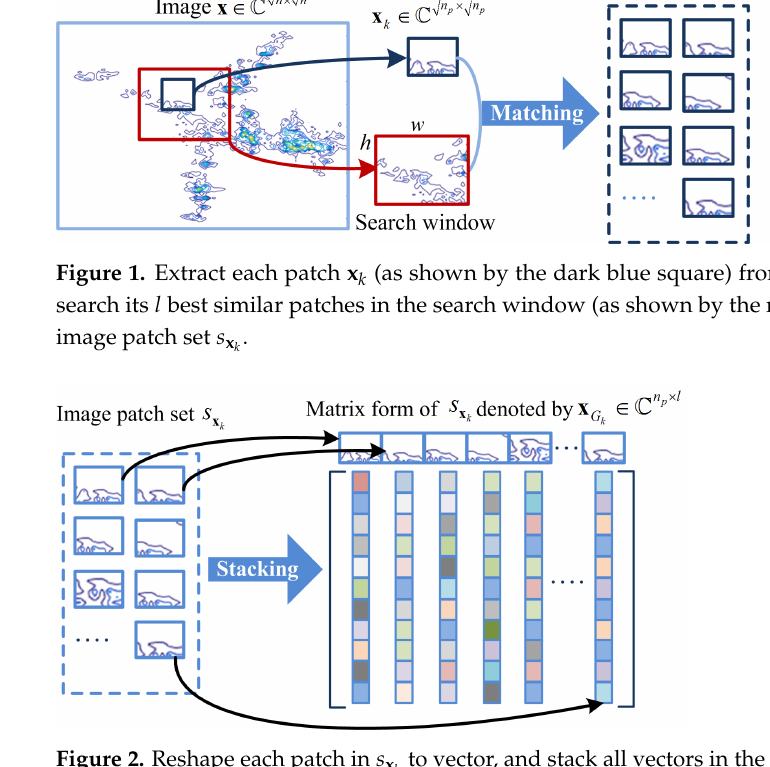
to vector, and stack all vectors in the form of matrix to construct k . k